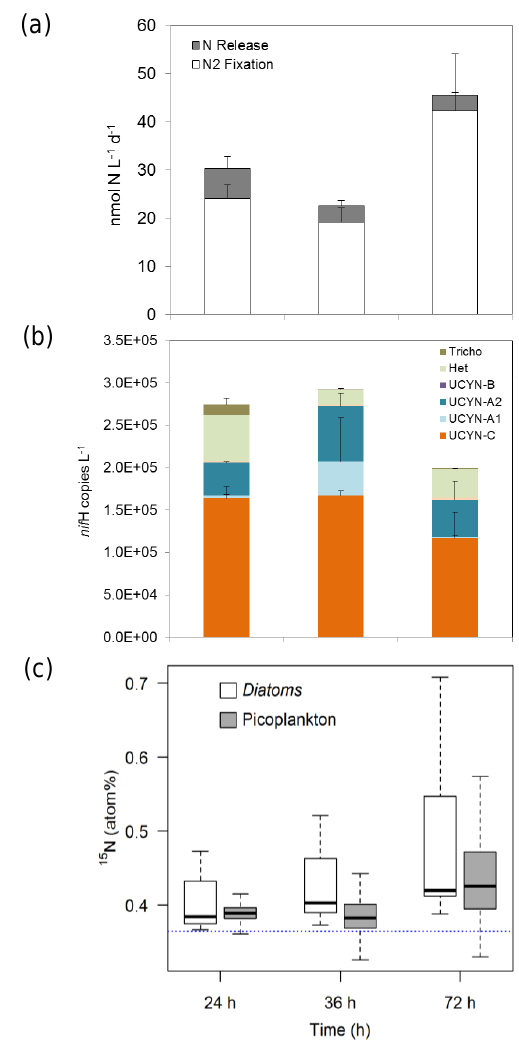
Figure 5. Results from the DDN transfer experiment performed from day 17 to 20 in M2. (a) Temporal changes in 15 N 2 up- take (white,nmolNL − 1 ) and quantification of DDN in the dis- solved pool (grey) over the course of the experiment. Error bars represent the standard deviation of three independent replicate in- cubations. (b) Temporal changes in diazotroph abundance deter- mined by qPCR ( nif HgenecopiesL − 1 ) during the same experi- ment. Error bars represent the standard deviation of triplicate in- cubations. (c) Summary of the nanoSIMS analyses. Measured 13 C and 15 Nat.% values of non-diazotrophic diatoms (white) and pi- coplankton (grey) as a function of incubation time. The horizontal dashed line indicates the natural abundance of 15 N (0.366at.%), and the error bars represent the standard deviation for the several cells analyzed by nanoSIMS.